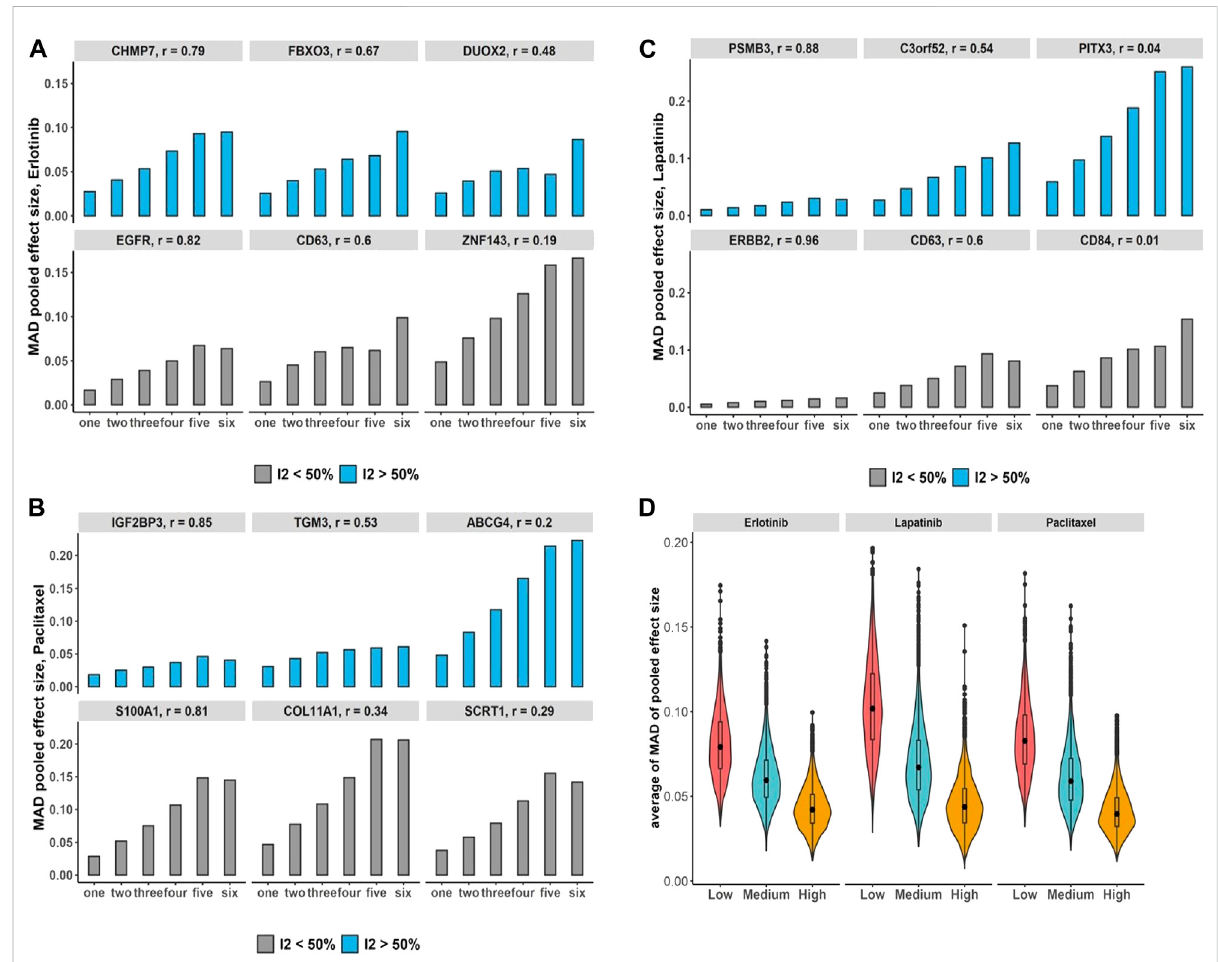
FIGURE 5 Breastcancernon-independentmeta-analyses: (A – C) barplotsdemonstrateincreasesinthenumberofduplicationsanditsimpactonthebias of estimated overall effect using MAD metric across drugs and selected genes with substantial (blue) and non-substantial (gray) estimated heterogeneity estimation. Note that x -axis presents the number of duplicate study effects. (D) Violin plots show average of MAD values across non- independent analysespergenesovermedianofPearsoncorrelationofeachgene ’ sexpressionacrossstudies:low(| r | < 0.3),medium(0.3 ≤ | r | < 0.7), and high (| r | ≥ 0.7). Black dot at the box plot represents the